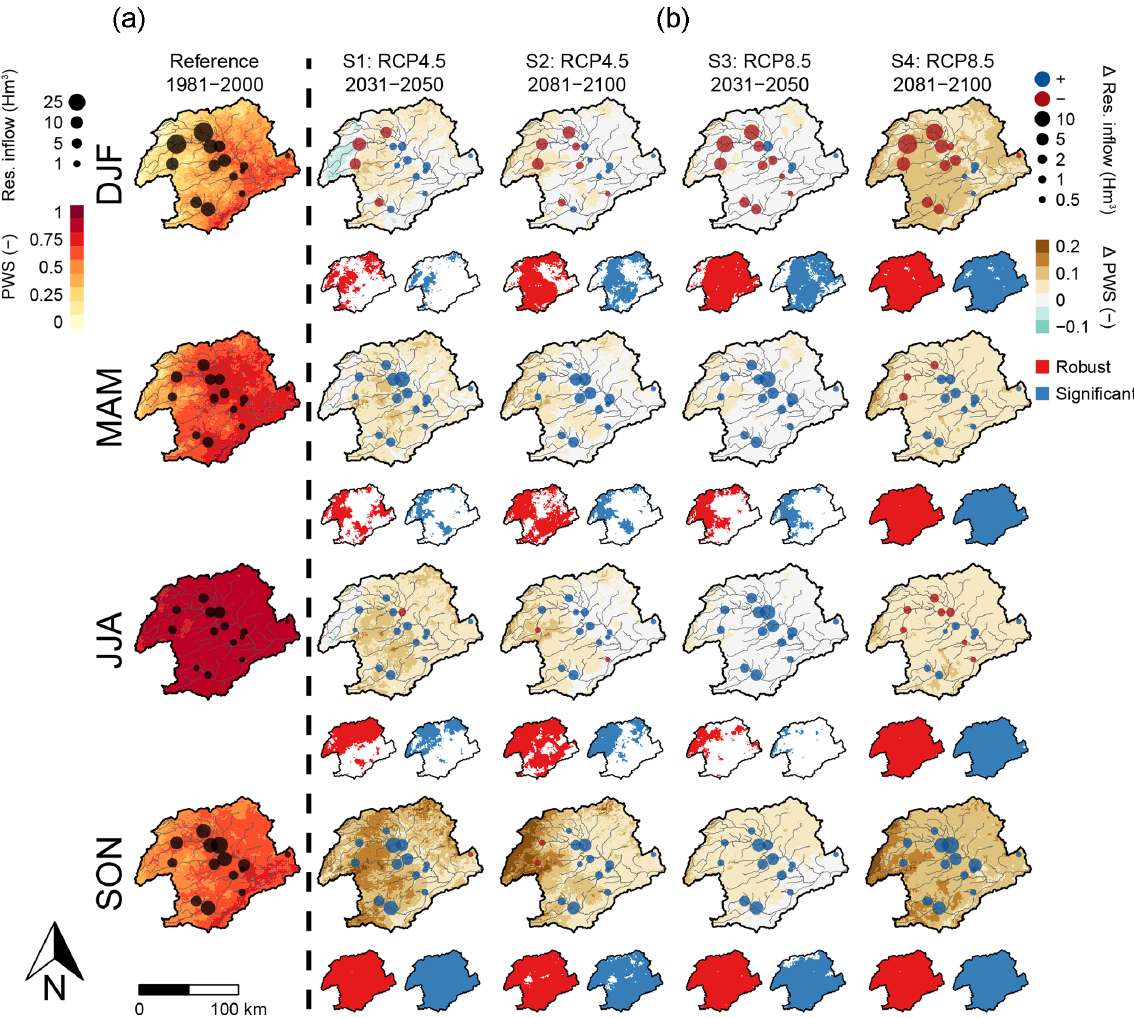
Figure 4. Ensemble average seasonal reservoir inflow (dots, Hm 3 ) and plant water stress (PWS) (–) for the reference scenario (a) and changes between the reference scenario and the four future scenarios (b) , differentiated by season: winter (DJF), spring (MAM), summer (JJA), and autumn (SON). For the future scenarios, the reservoir inflow is presented as an increase (blue) or a decrease